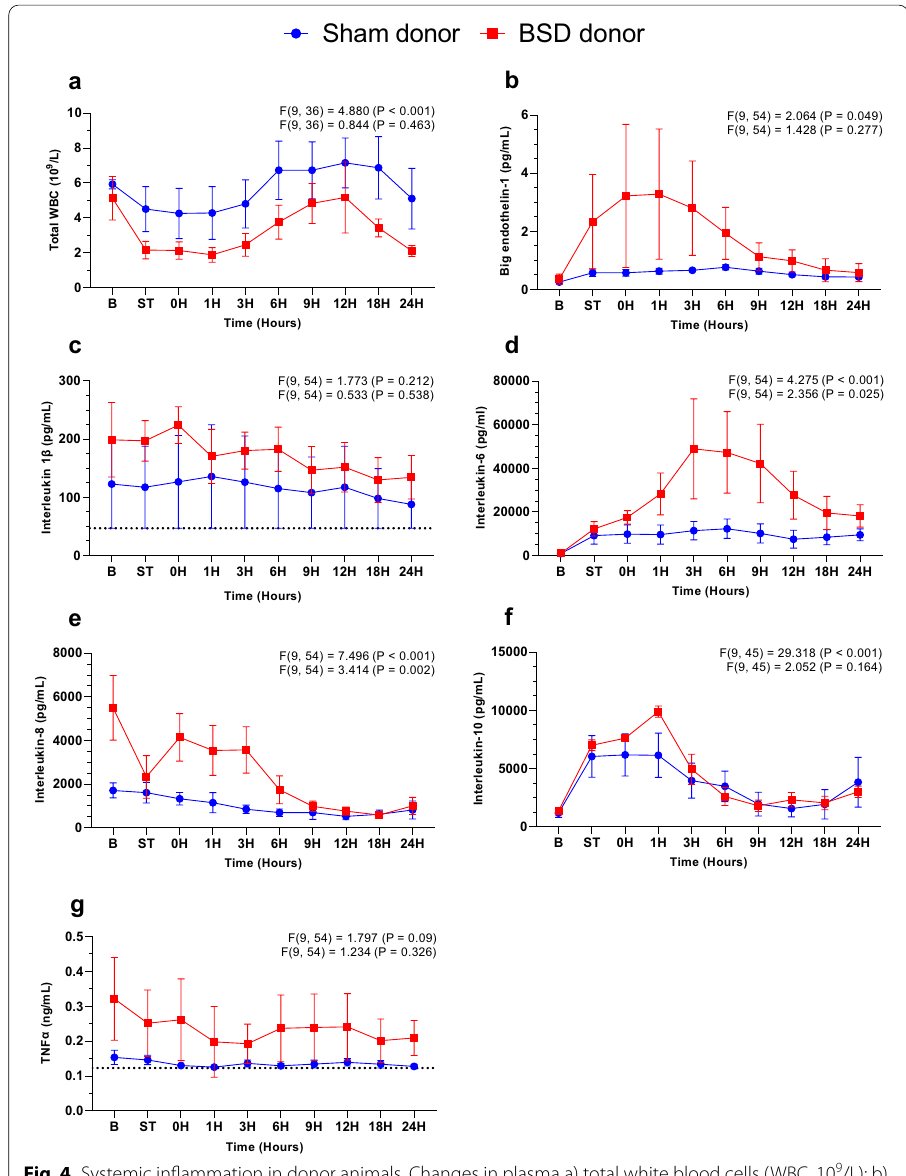
Fig. 4 Systemic inflammation in donor animals. Changes in plasma a) total white blood cells (WBC, 10 9 /L); b) big endothelin‑1 (BET‑1, pg/mL); c) interleukin 1β (pg/mL); d interleukin‑6 (pg/mL); e interleukin‑8 (pg/mL); f interleukin‑10 (pg/mL); and g tumour necrosis factor alpha (TNFα, ng/mL) following confirmation of donor BSD (or sham). Data are mean SEM, n 4/group. Top F and p values on each graph represent effect of time, ± = and bottom F and p values represent differences between BSD vs. sham over time. B Baseline, ST stabilisation 1 h following completion of instrumentation procedures in donor, 0H—confirmation of BSD. Dotted lines on c and g represent the lowest detectable limit of the respective cytokine